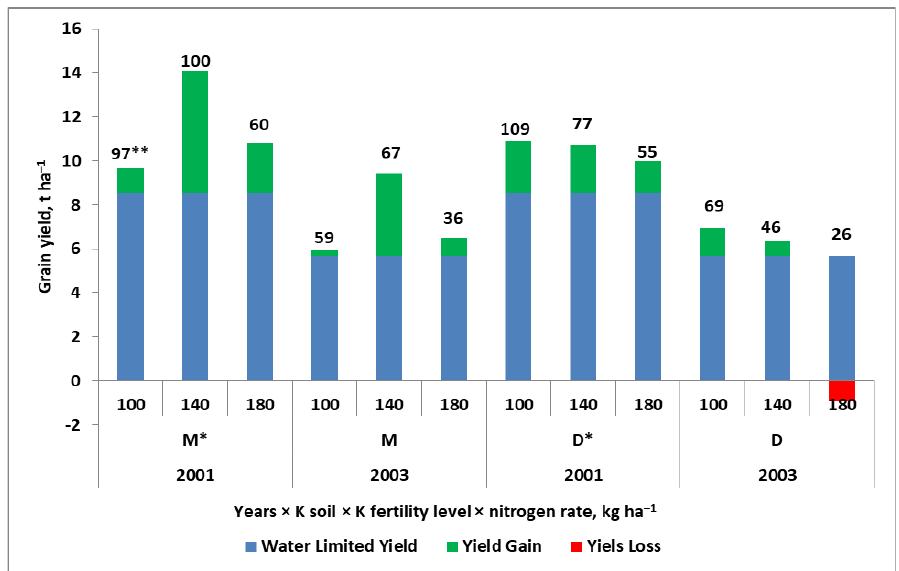
Figure 9. Effect of K soil fertility on maize yield in two years differing in water regime (modification based on [144]). Legend: * soil K fertility level: M, medium, D, high; ** Partial factor productivity of N f (kg grain kg ─ 1 N f ).